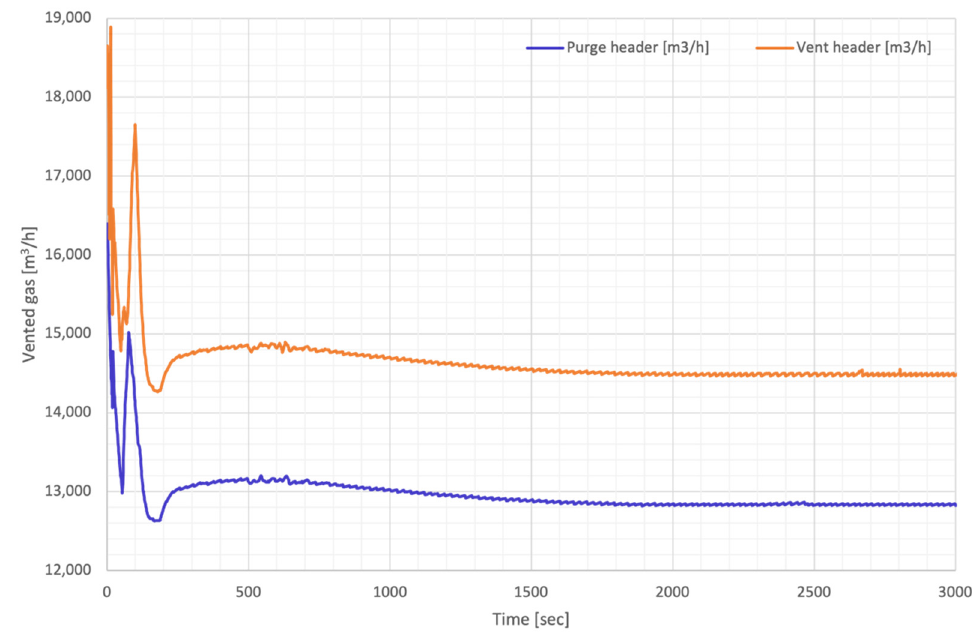
Figure 14. Volumetric gas flow vented by each 20 inches piping.